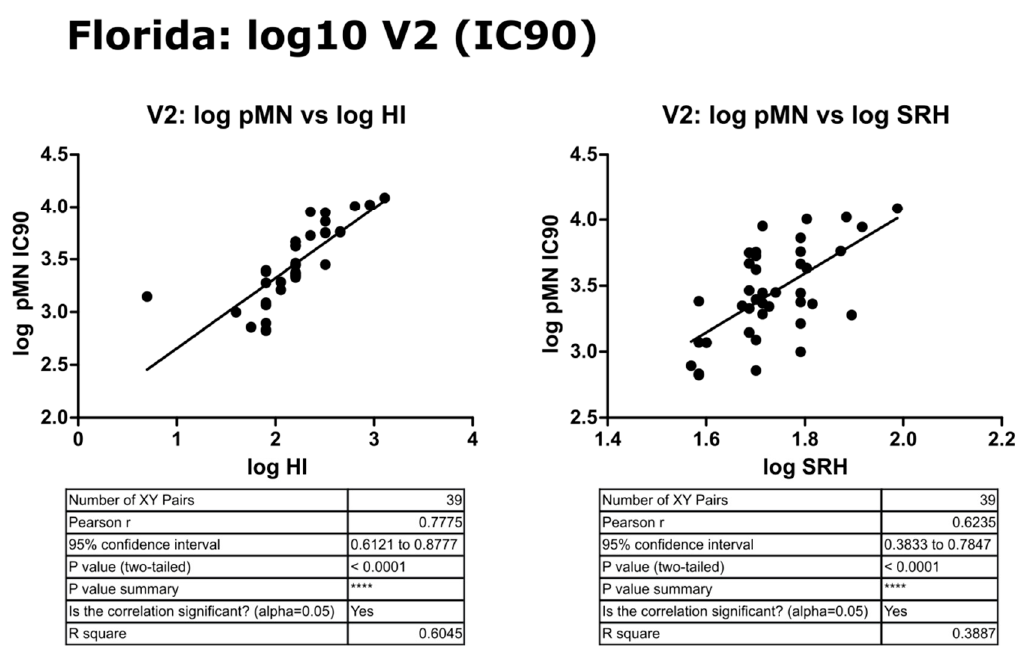
Figure 14. Correlation of transformed (log10) data for pMN (IC 90 ) with SRH and HI mean V2 values, assayed against B/Florida/4/2006 PV. Pearson’s two-tailed analysis performed using GraphPad Prism. Strong correlation was observed between log IC 90 antibody titres and log HI or SRH values, with Pearsons r values of 0.77 and 0.62, respectively. p ≤ 0.0001 = ****.